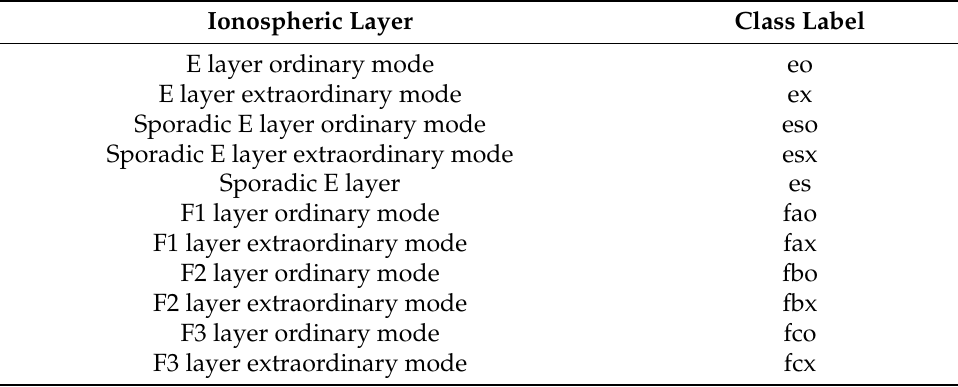
Table 1. The 11 ionospheric layers with their corresponding class labels.